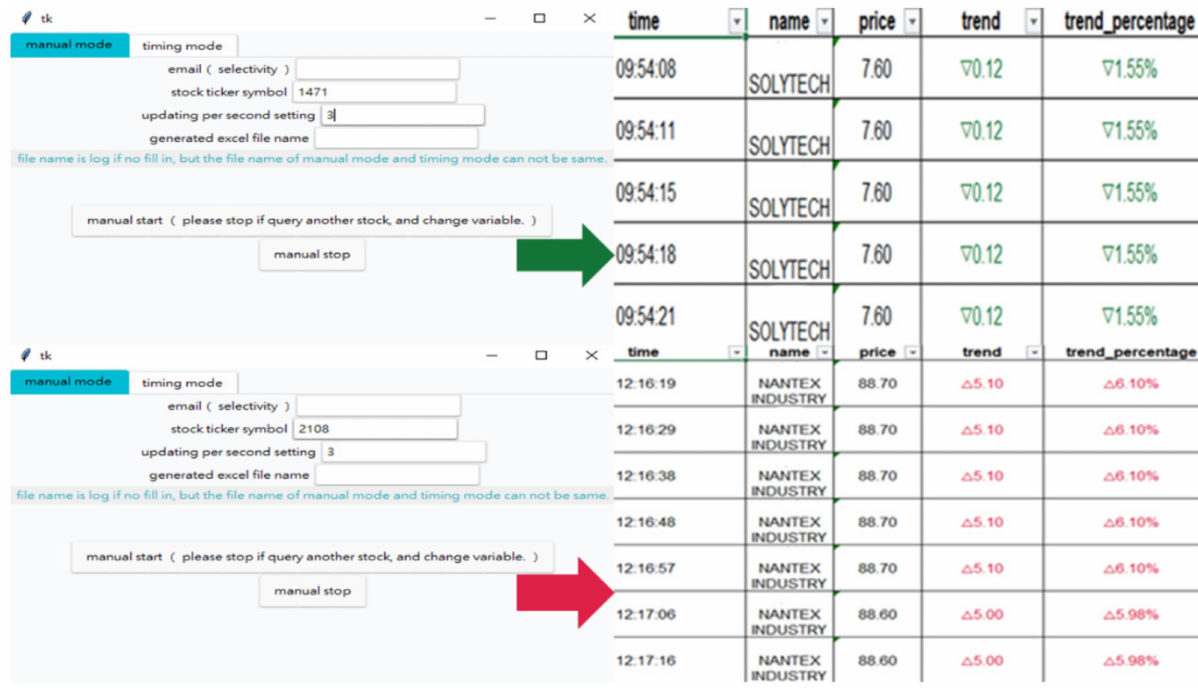
Figure 10. Manual mode and transfer to Excel